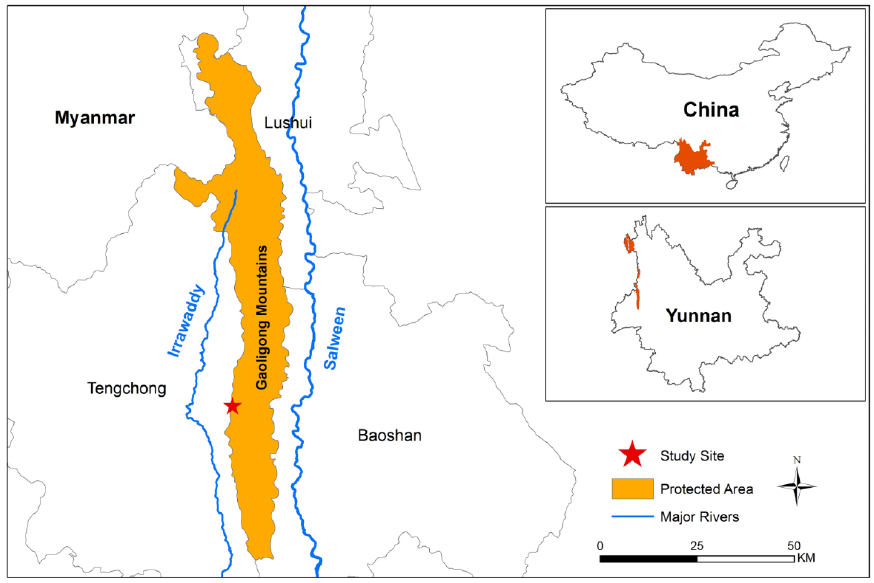
Figure 1. Geographical location of the study site.